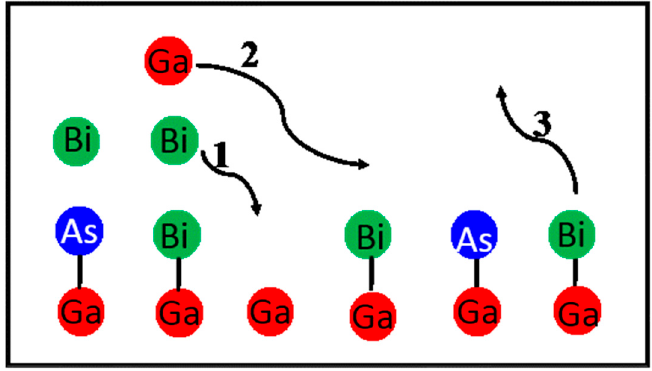
Figure 6. Schematic illustration of three processes in Lewis’ GaAsBi growth model. Reproduced from Reference [136].